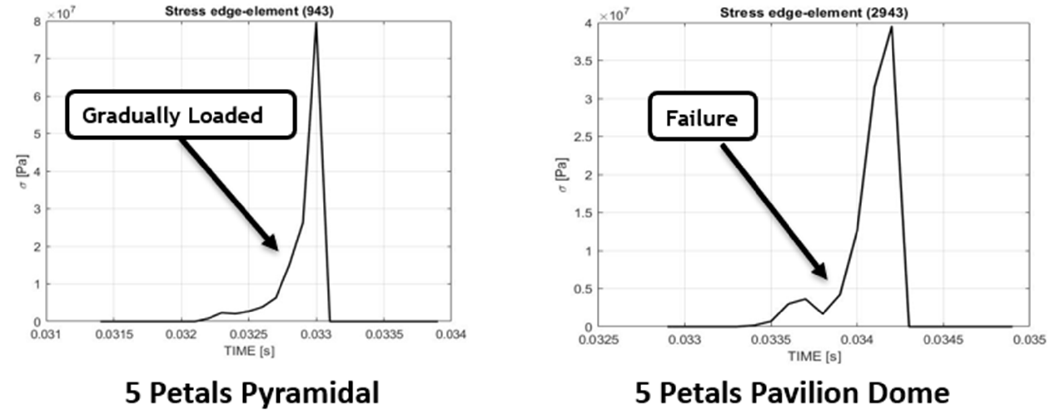
Figure 16. Pyramidal and Pavilion Dome Tailgate configuration: Stress evaluation. Table 4. Numerical results.